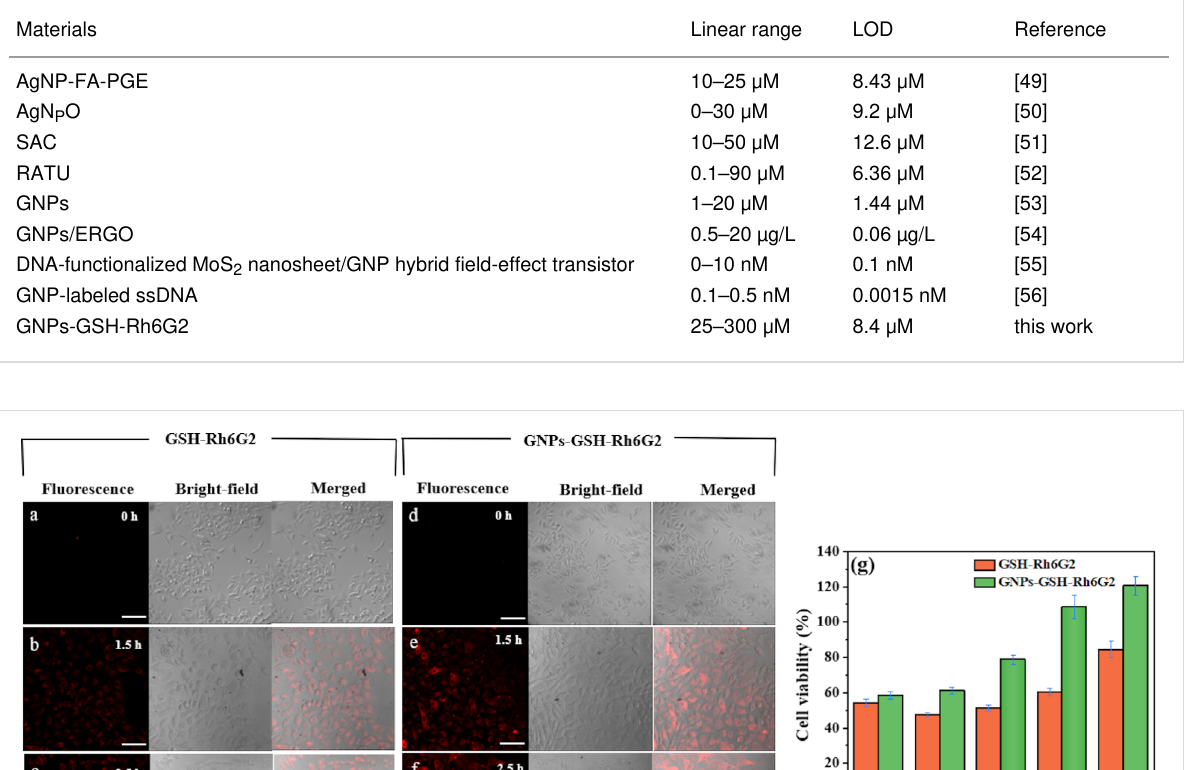
Table 1: Comparison of GNPs-GSH-Rh6G2 with other strategies for Hg 2+ detection.